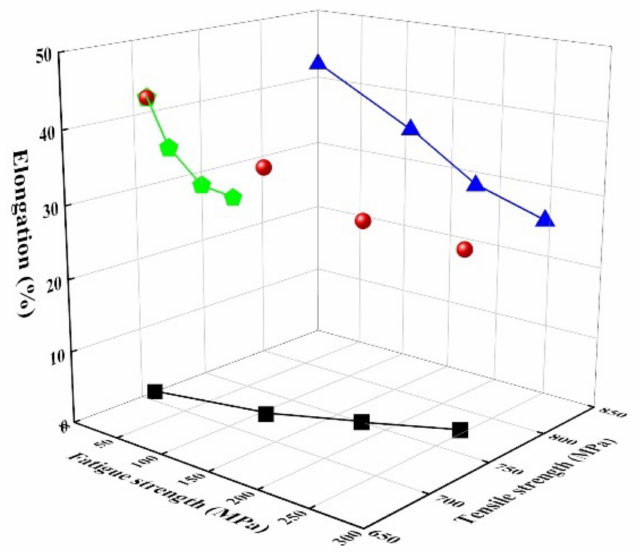
Figure 5. Mechanical properties of Fe-22%Mn-12%Cr-4%Co-3%Ni-2%Si damping alloy as a function of fatigue strength. Green pentagons: The relationship between elongation and tensile strength, blue triangles: The relationship between fatigue strength and elongation, and black squares: The relationship between fatigue strength and tensile